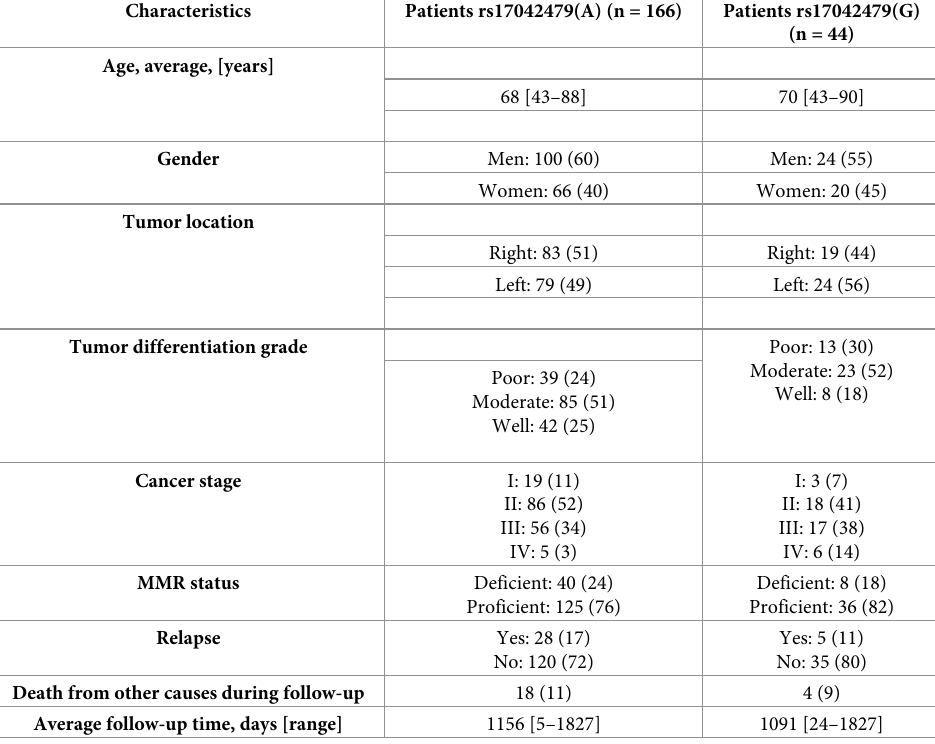
Table 1. Overview of cancer characteristics for patients homozygotic for the reference allele (Patients rs17042479 (A)) and for patients heterozygotic for the risk allele of SNP rs17042479 (Patients rs17042479(G)). One patient was homozygotic for the risk